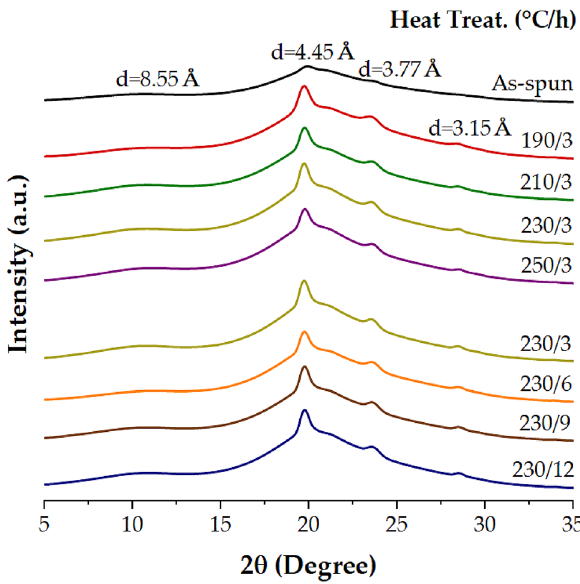
Figure 6. XRD patterns of TLCP fibers with various heat treatment